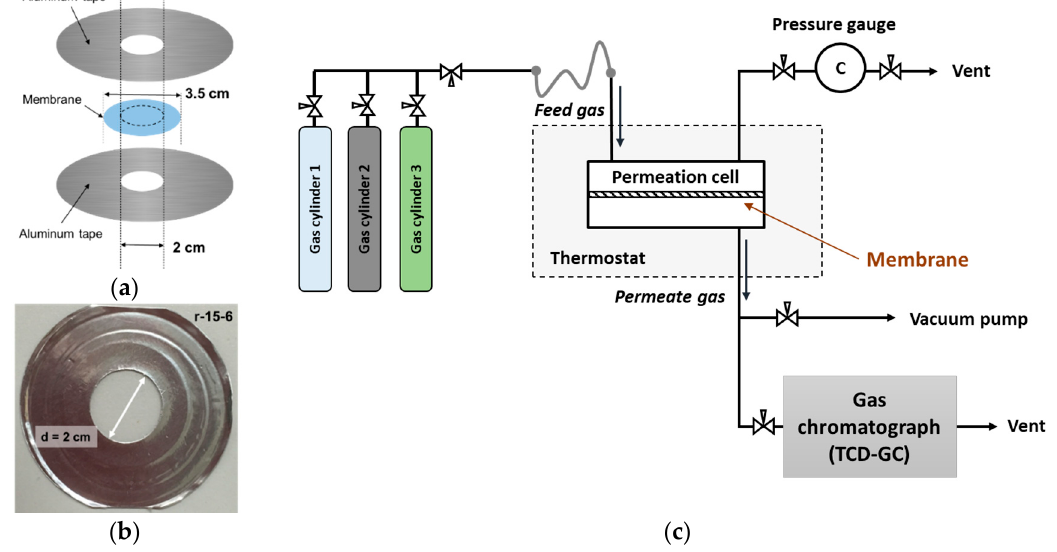
Figure 2. ( a ) Schematic image of DMS@POSS membrane assembly for the gas transport measurement in GTR-TEC machine; ( b ) Photography of the typical sample used for gas permeability measurements ( c ) schematic image of the steel cell used for gas transport measurement in the GTR-TEC device.